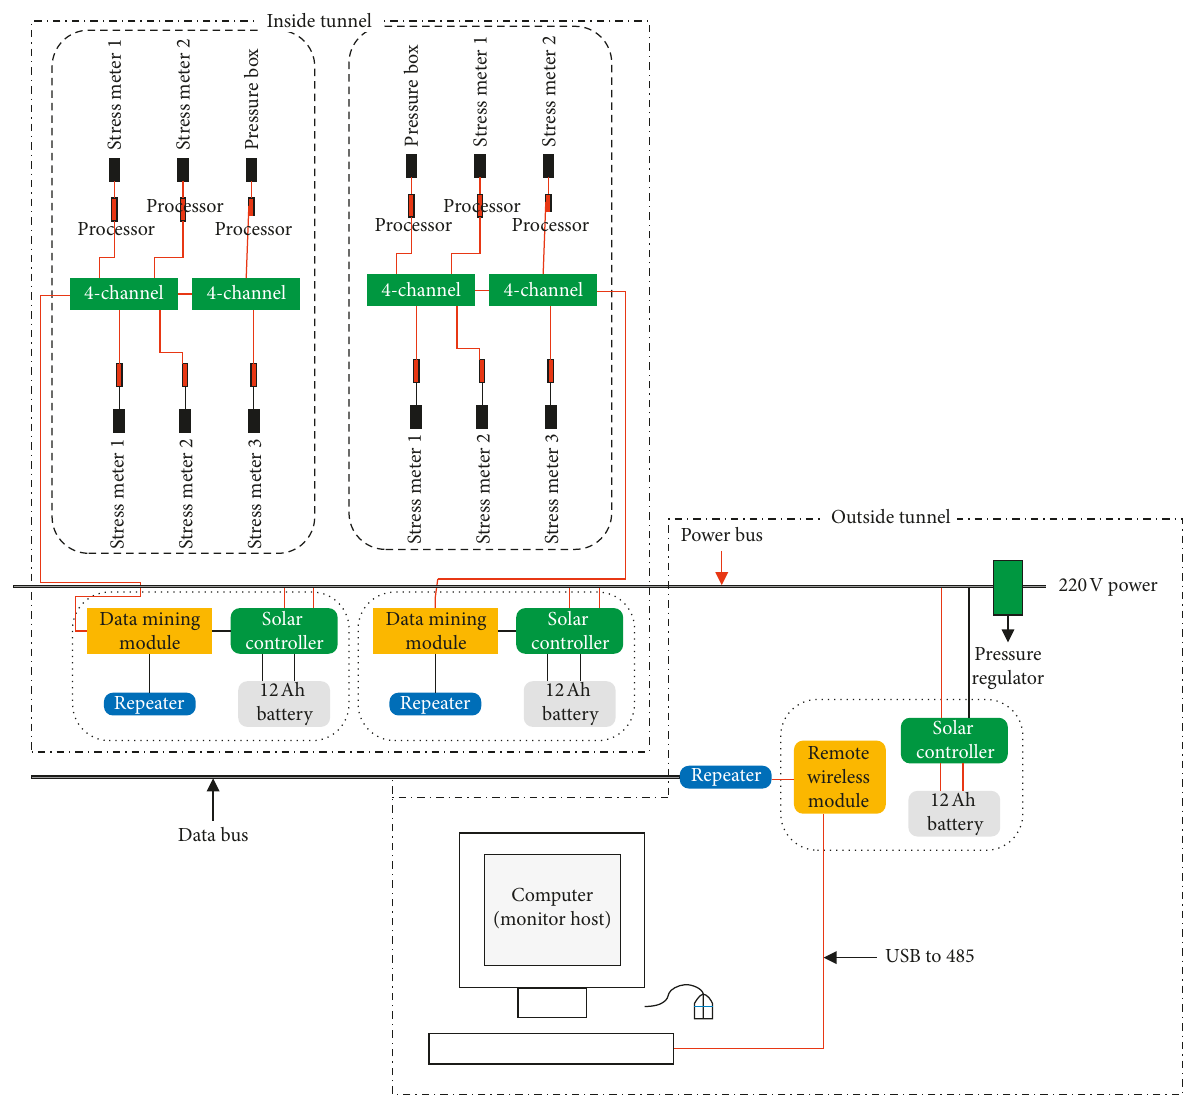
Figure 3: Schematic of wired network inside tunnel +wireless network and data